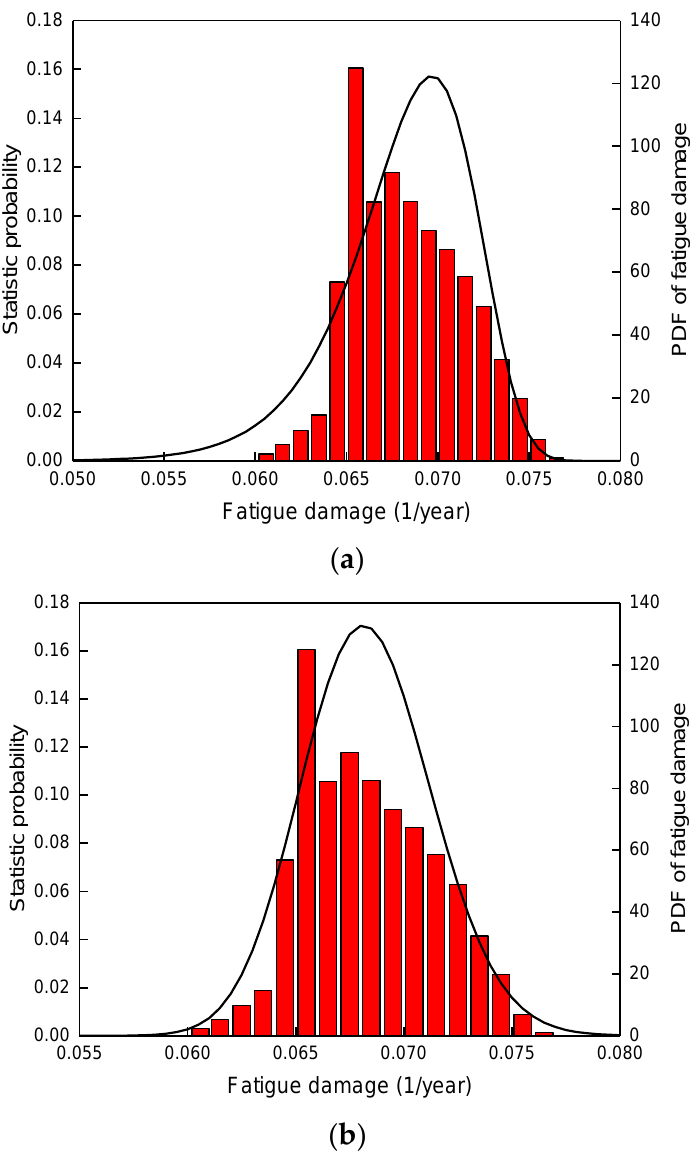
Figure 11. PDF of fatigue damage of LW weld. ( a ) Weibull distribution. ( b ) Lognormal distribution.